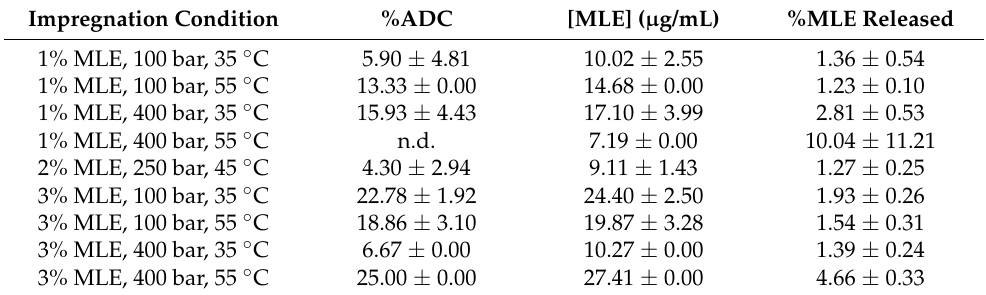
Table 3. Migration of MLE from impregnated filaments; percentage of ADC, concentration of MLE released into the medium and proportion of MLE released from each sample. Impregnation Condition %ADC [MLE] ( µ